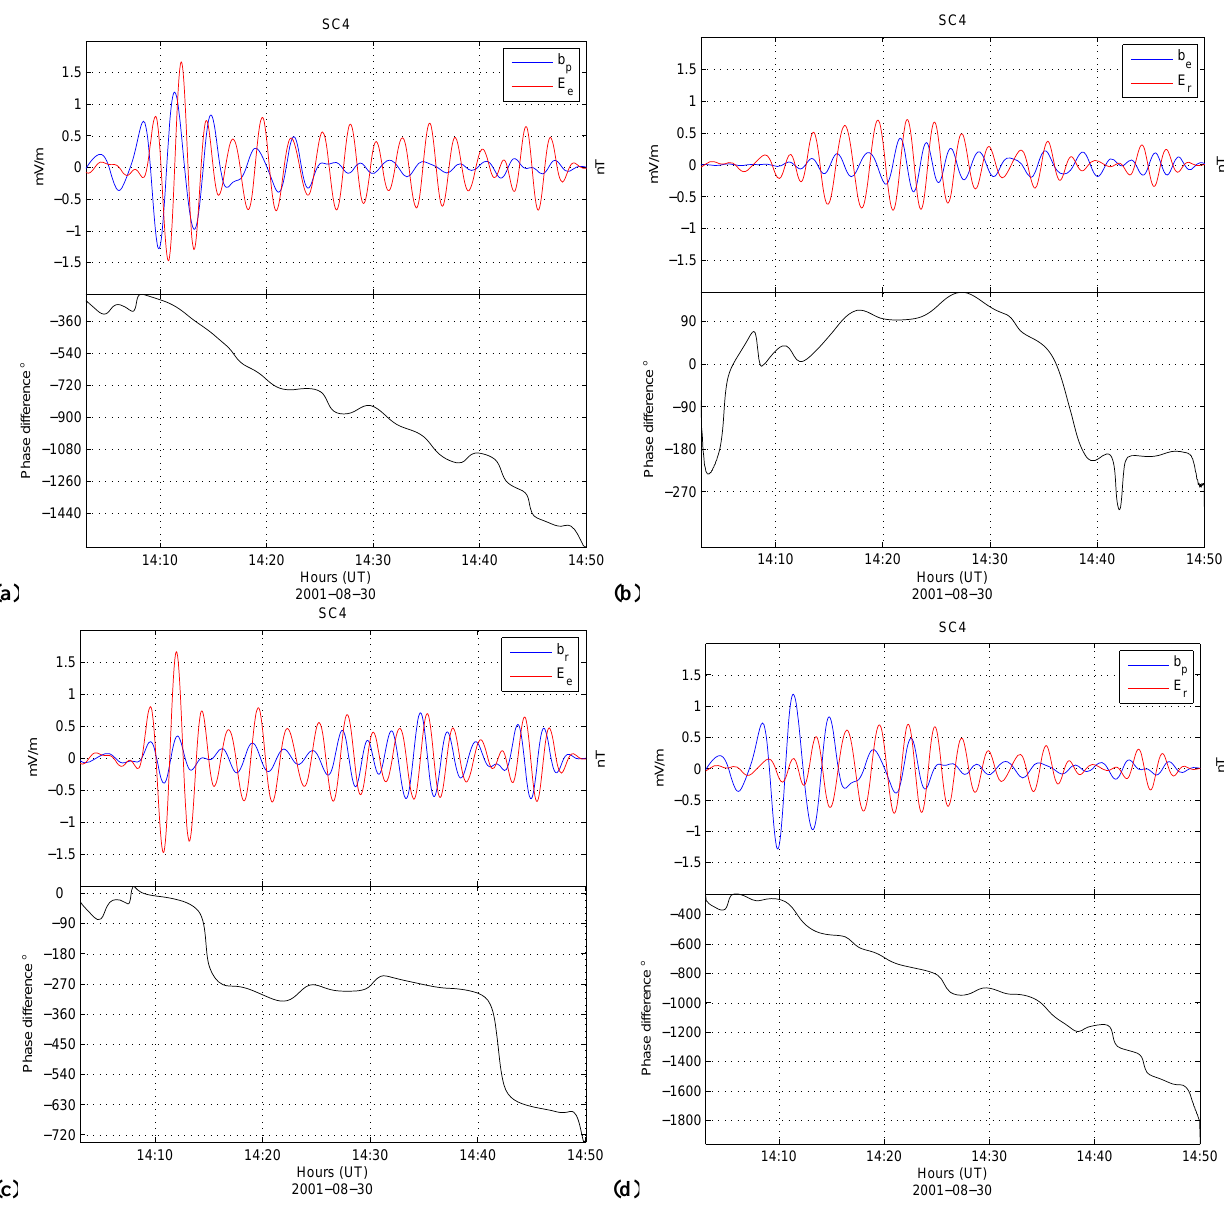
Fig. 7. The top panel in each figure shows one bandpass filtered (passband 4–9mHz) component of the electric field (red) and one component of the magnetic field (blue) measured by SC 4. The bottom panel shows the instantaneous phase difference between these two components. (a) Shows the eastward electric field component and the parallel magnetic field component; (b) the eastward magnetic and radial electric field components; (c) eastward electric and radial magnetic field components; (d) parallel magnetic and radial electric